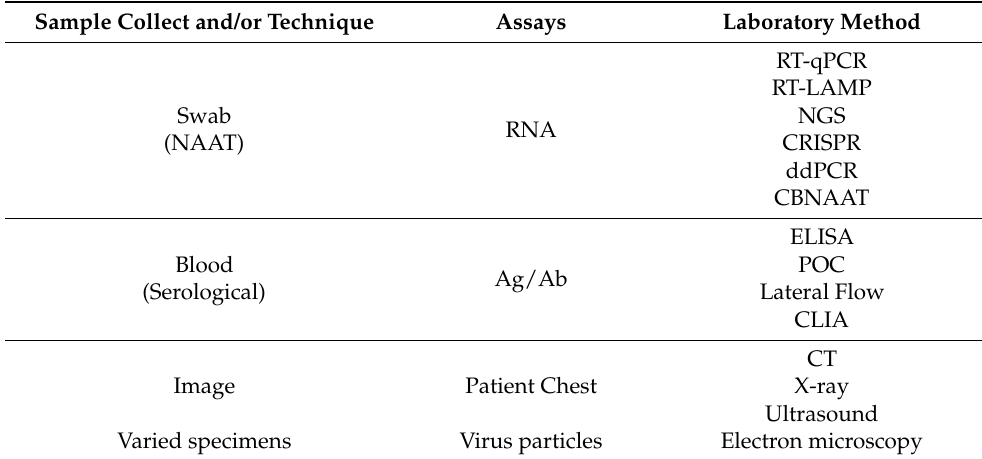
Table 5. Analytical methods available for SARS-CoV-2 detection according to samples (techniques), assays, and laboratory